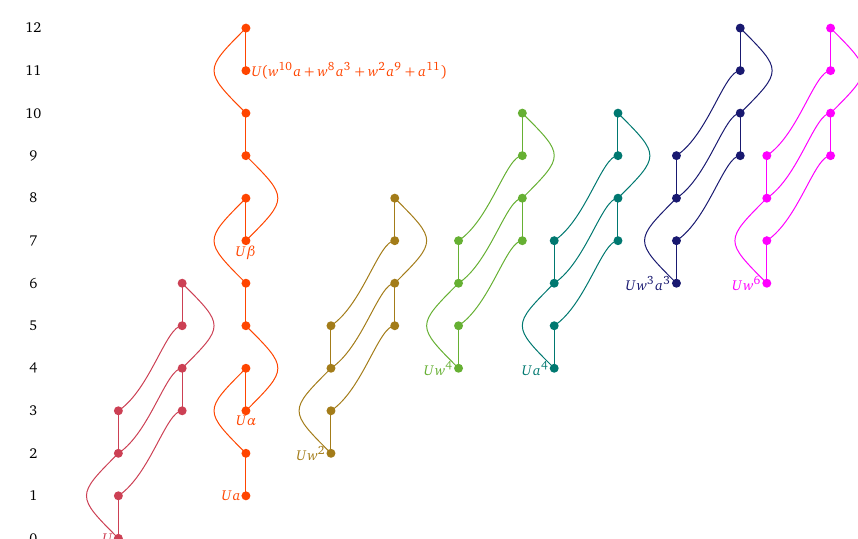
) contains all elements of degree at most Figure 6: This A ( 1 ) -submodule of (cid:101) H ∗ ( X ; (cid:70) 2 7. Each dot represents an (cid:70) summand, with its cohomological degree given by 2 its height. The connecting lines, resp. curves, indicate an action by Sq 1 , resp. Sq 2 , carrying the lower dot to the upper dot. This A ( 1 ) -module factors as several different summands; we give each summand a different color. In the generators of the orange summand, α : = w 2 a + a 3 and β : = w 6 a + w 4 a 3 + w 2 a 5 + a 7